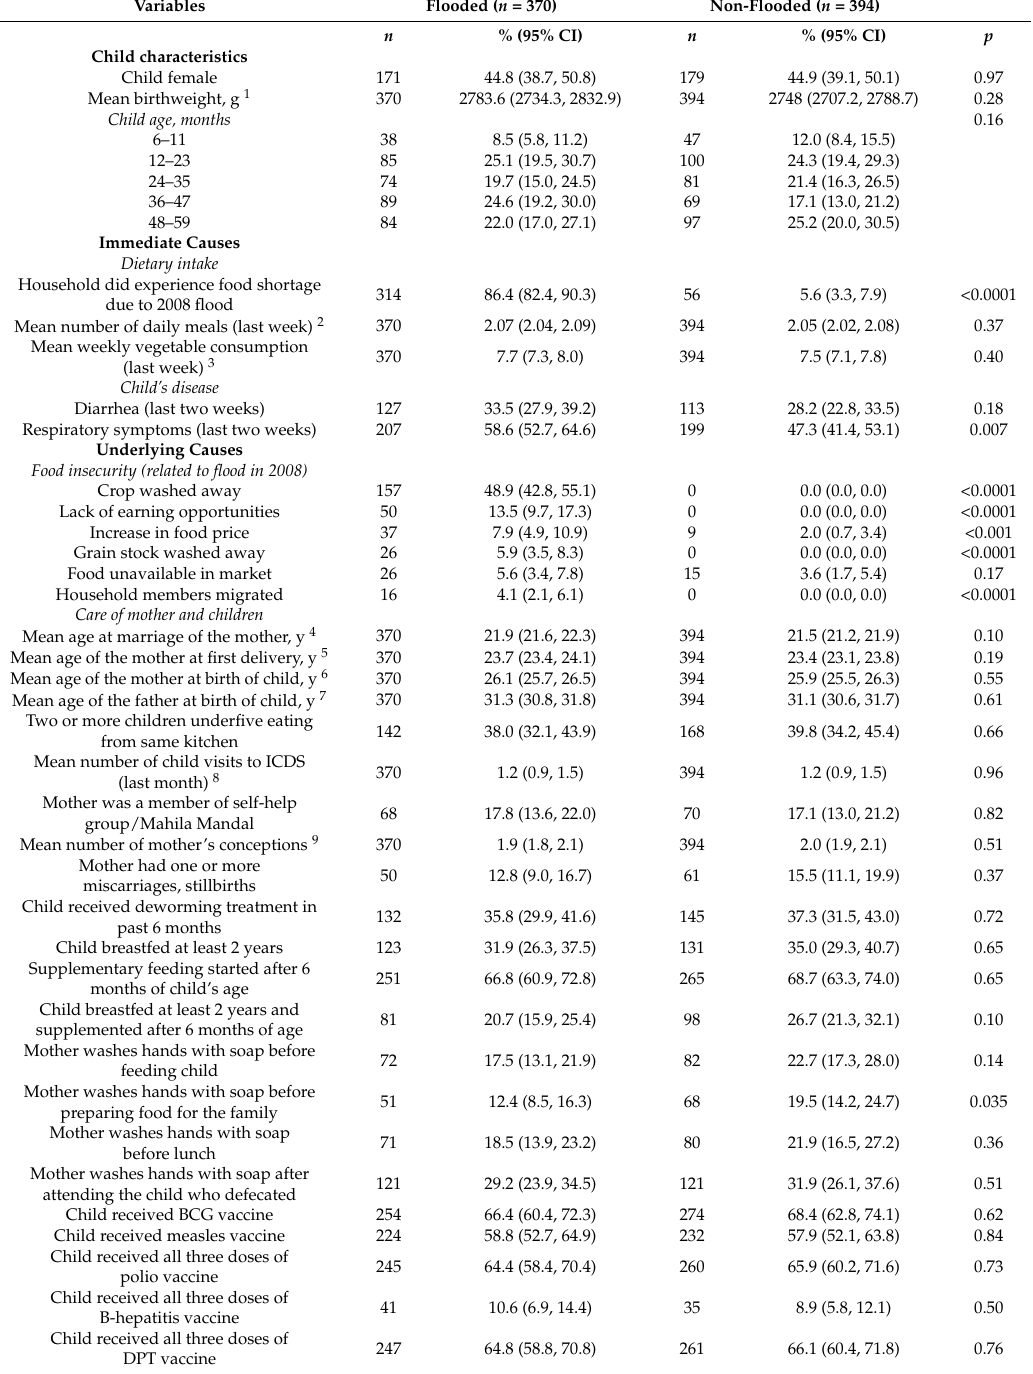
Table 1. Determinants of child undernutrition in flooded (in 2006 and 2008, or 2008) and non-flooded communities of rural Jagatsinghpur district, Odisha, India in September 2009.